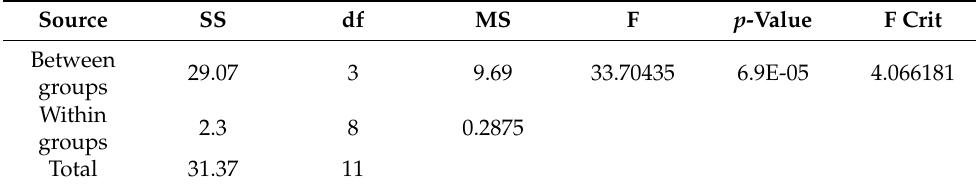
Table 7. Analysis of variance results for variation of seedling injury rate with working